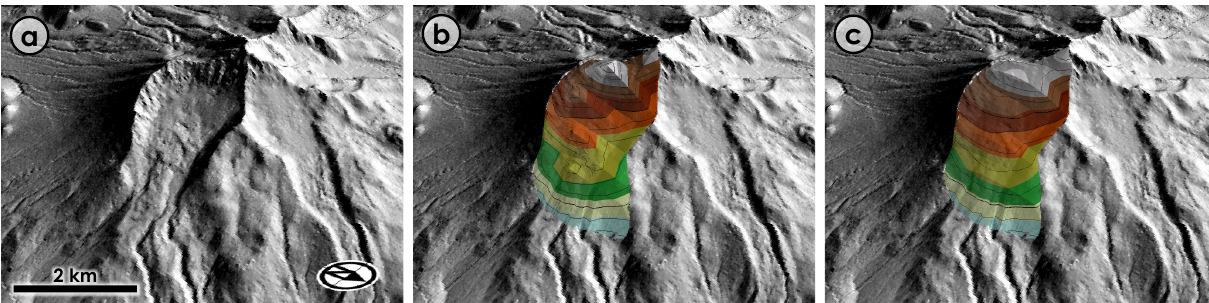
Figure 12. Bird’s eye view of the reconstructed source area of the sector collapse. (a) Present topography of the scar. (b) Three-dimensional TIN of the reconstructed surface of the original edifice by linear extrapolations. (c) Three-dimensional TIN of the reconstructed surface of the original edifice by Bézier curve